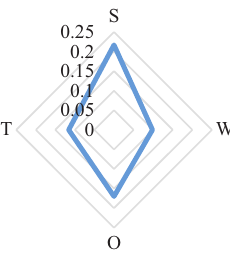
Figure 8. The application of SWOT matrix for SNC SO strategies focus on utilizing the opportunities from external environments by using internal strengths.